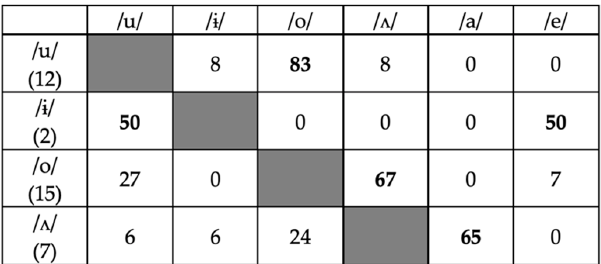
Figure A5. Confusion matrix of errors by the some-contrast group in the posttest for vowel items (vertical = stimuli, horizontal = responses). Each cell shows the percent of all errors on the given stimulus represented by the given response (rows may not add to 100% due to rounding); the most common error type for each stimulus is bolded. The total number of errors for each stimulus (across all participants in the group) is shown in parentheses.